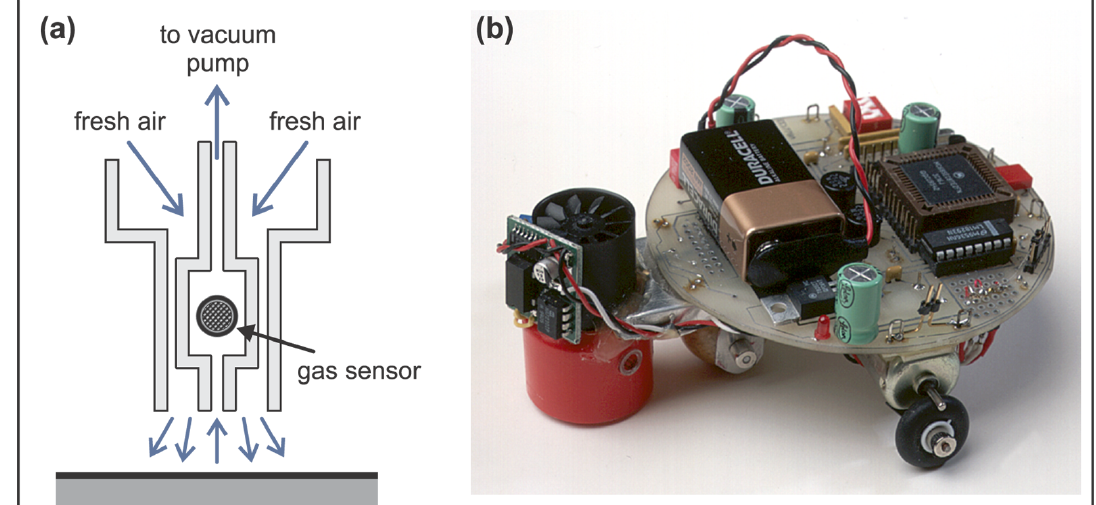
Figure 8 . Air curtain technique. (a) Illustration of the functional principle, adapted from Russell et al. [68]. Air is drawn from the floor through the sensor inlet and blown in the opposite direction around the sensor inlet. Thus, an outward airflow is created that is able to deflect gas carried towards the sensor by external air currents. (b) Image of the mobile robot “Nose-Bot” equipped with the improved gas sensor (photograph by courtesy of R. Andrew